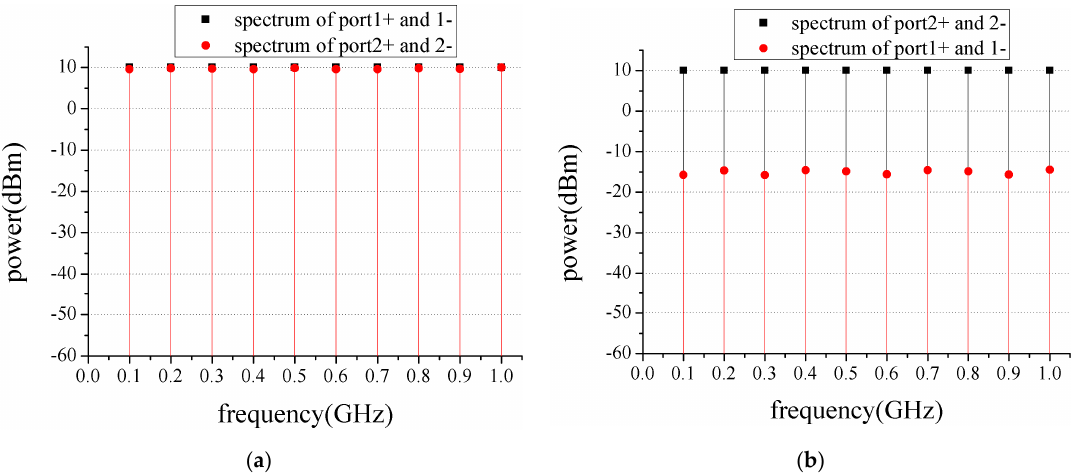
Figure 5. Spectrum analyzing results of the DTI. ( a ) Inputs from port 1+(1 − ); and ( b ) inputs from port 2+(2 − ).